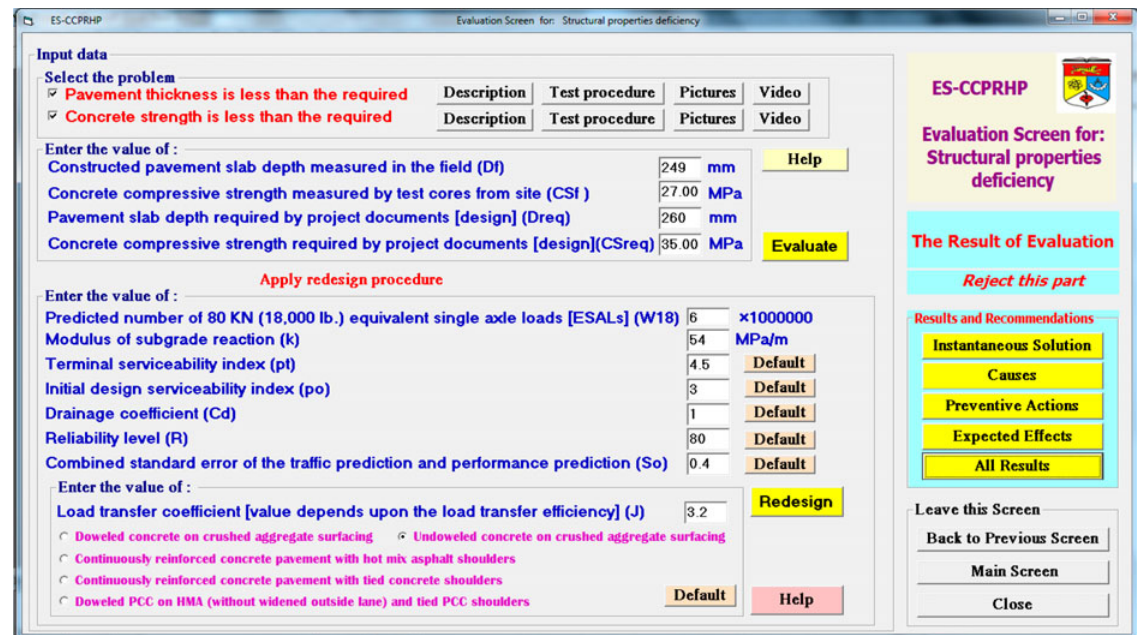
Fig. 4. ES-CCPRHP evaluation screen for structural property de fi